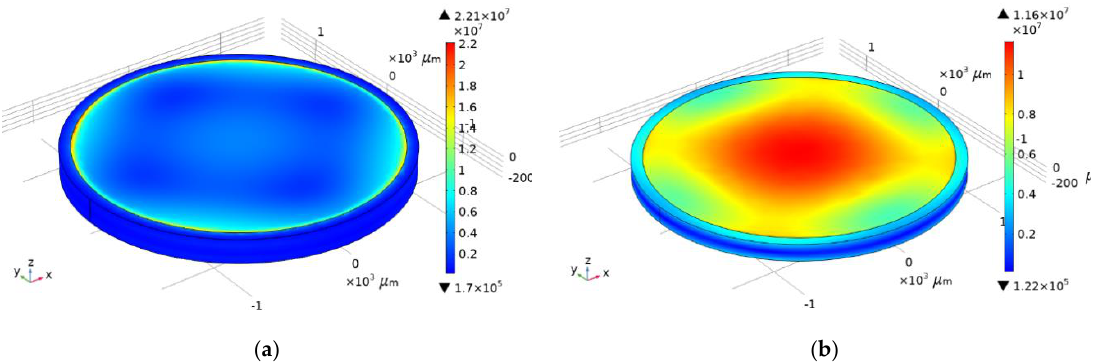
Figure 4. Load distribution for rigid attachment ( a ) and silicone adhesive ( b ).